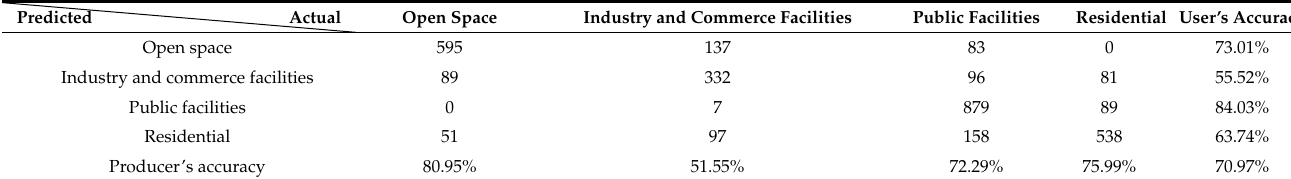
Figure 6. Identification results of urban functional regions (UFRs) for the Fifth Ring Road in Beijing. Table 3. Confusion matrix for the UFR identification